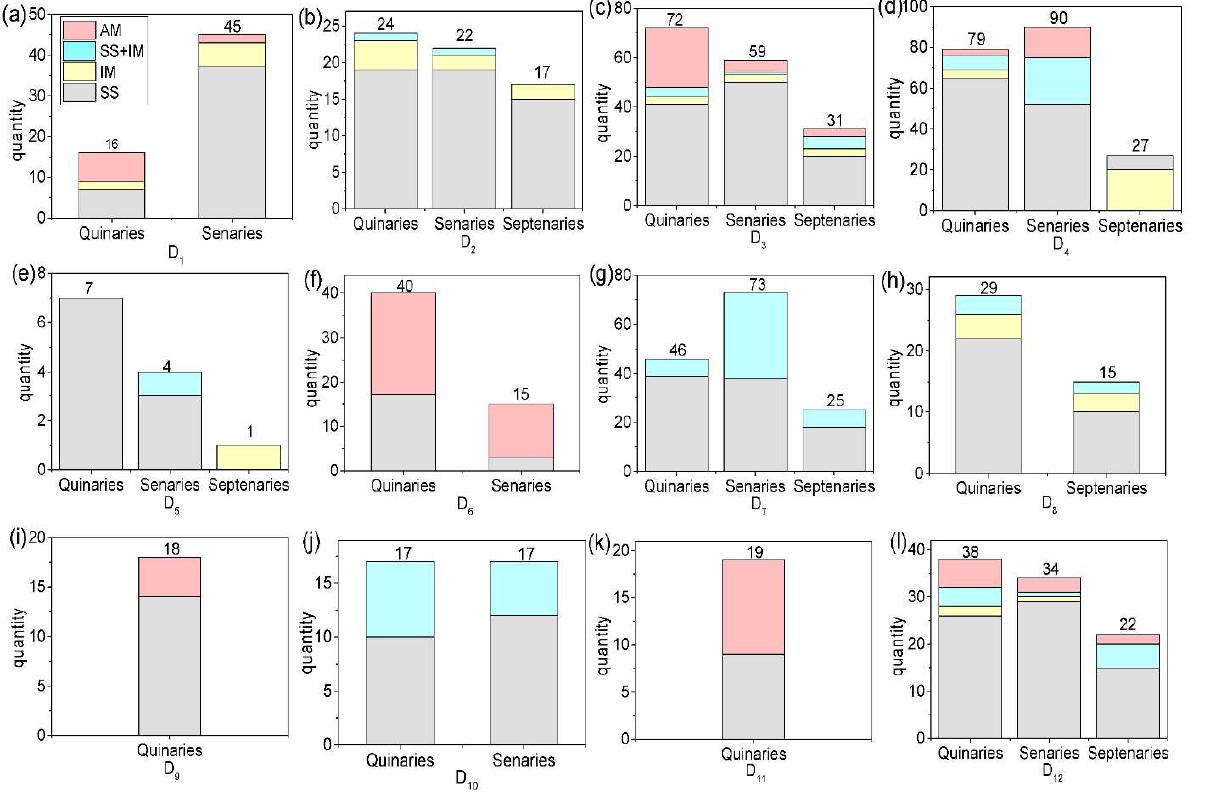
Figure 5. Quantity of SS, IM, SS+IM, and AM in the quinaries, senaries, and septenaries. ( a ) D1, ( b ) D2, ( c ) D3, ( d ) D4, ( e ) D5, ( f ) D6, ( g ) D7, ( h ) D8, ( i ) D9, ( g ) D10, ( k ) D11, and ( l ) D12.